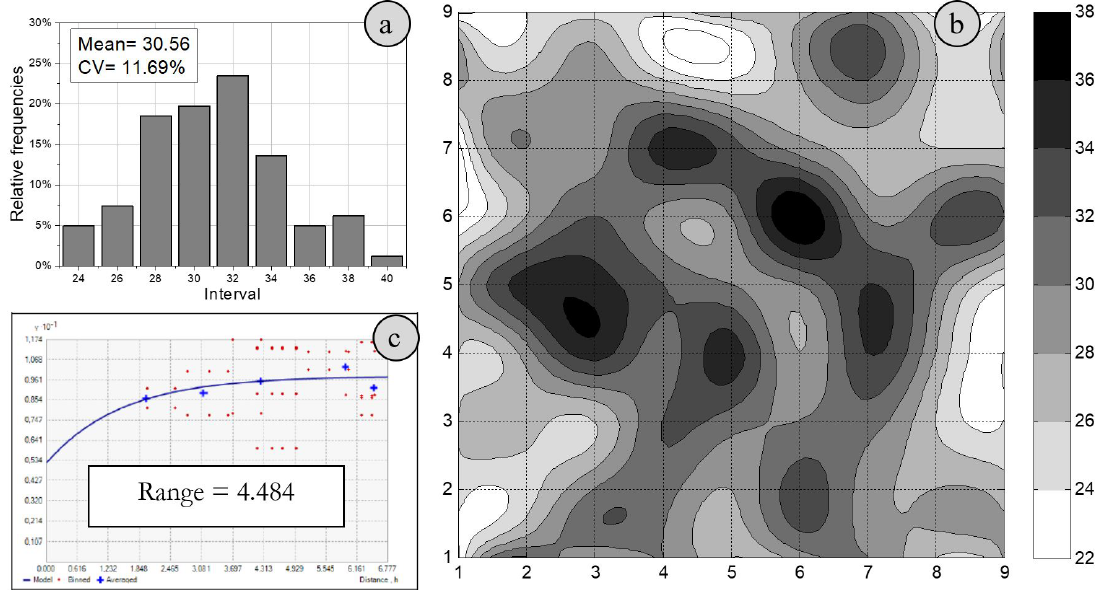
Figure 8. a) Histogram of the sclerometric index data, b) Spatial distribution and c) semivariogram with Gaussian model.